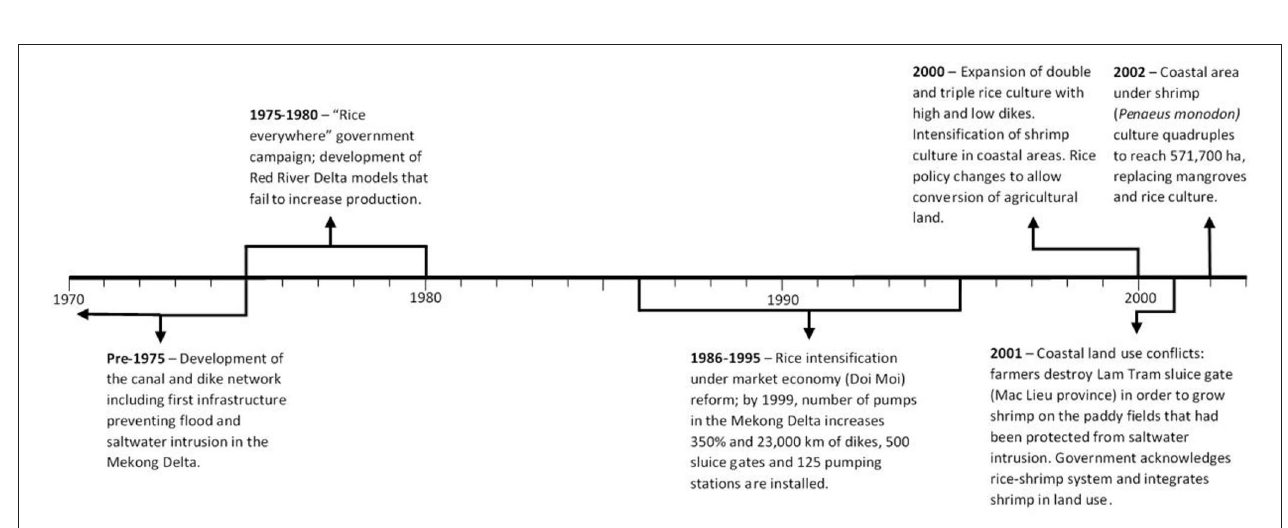
FIGURE 6 | Timeline of events that influenced rice-fish production practices in Vietnam’s Mekong Delta.